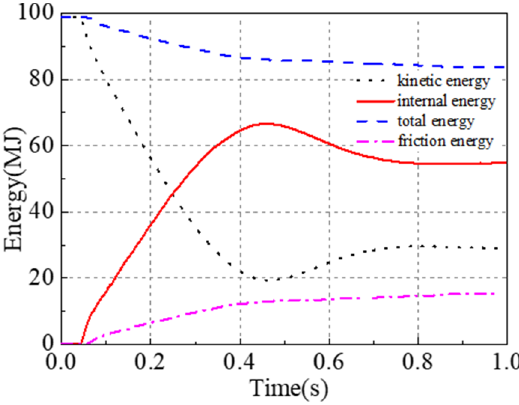
Figure 11. The time–history energy conversion of the collision system.